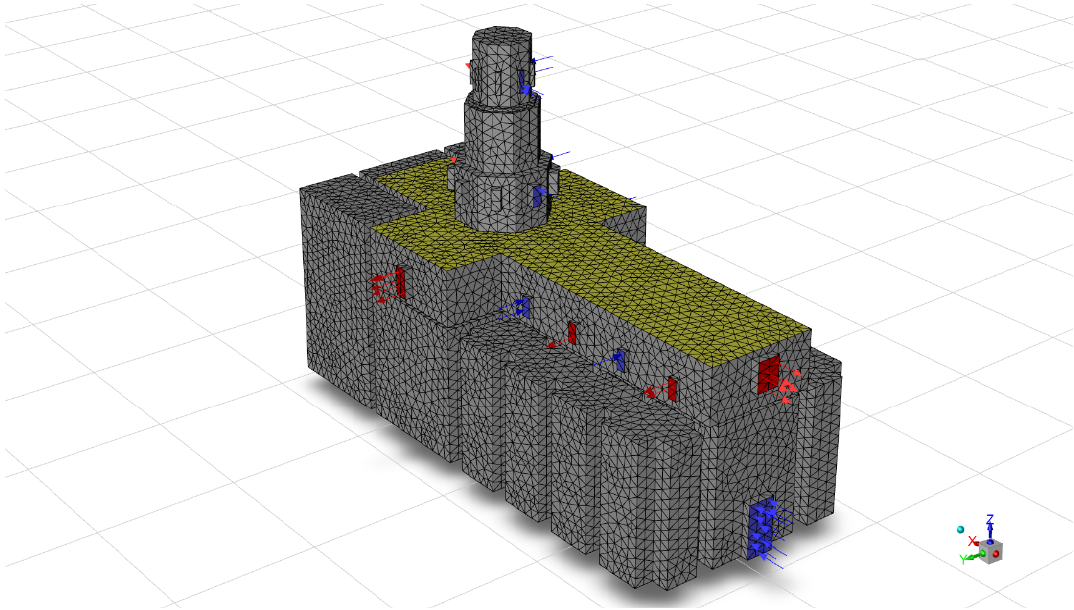
Figure 3. Finite element model used in calculations.